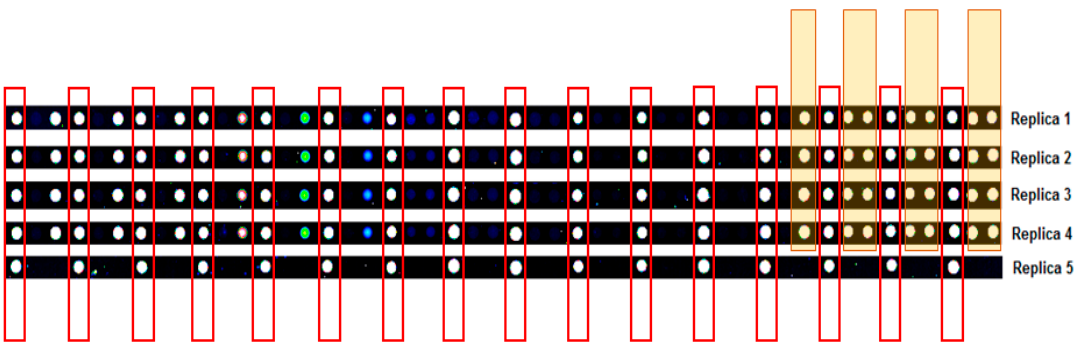
Figure 3 . Intra-protein, intra-slide and inter-array CV% of six IgG replica spots across all samples. The mean CV% for all samples was found to be 5.903%. Blue line represents the mean CV% for each sample.